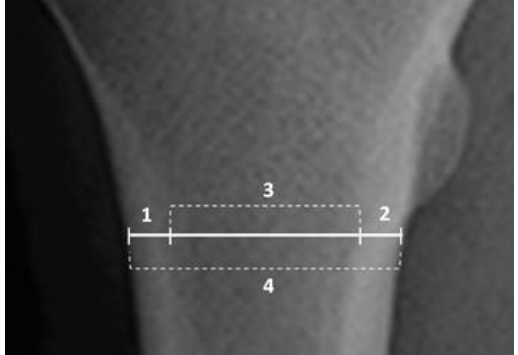
Figure A2. Representative femoral Anterior–Posterior plain radiograph indicating the measures of lateral cortical thickness (1), medial cortical thickness (2), M ‐ L medullary width (3) and femoral width (4).